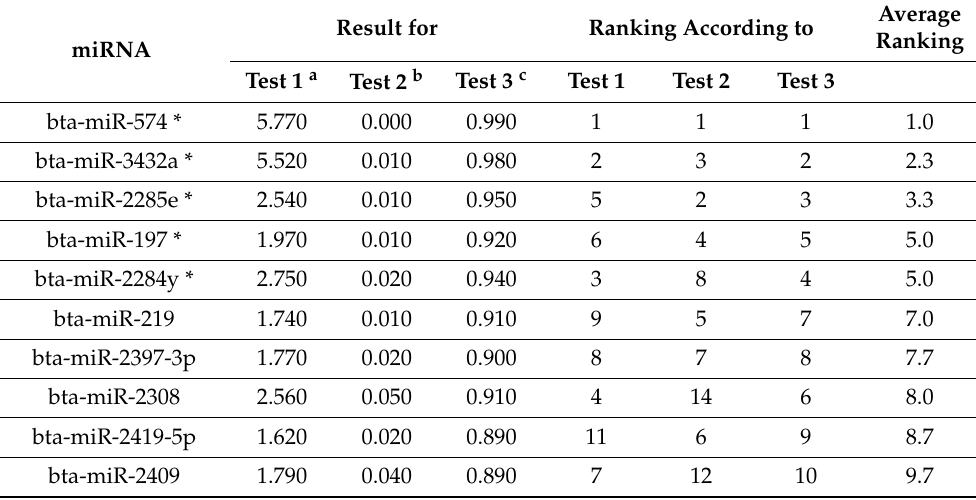
Table 6. Ranking average of the first ten differentially expressed miRNAs in the cellular fraction, the three applied tests’ values, and their rankings. Result for Ranking According to miRNA